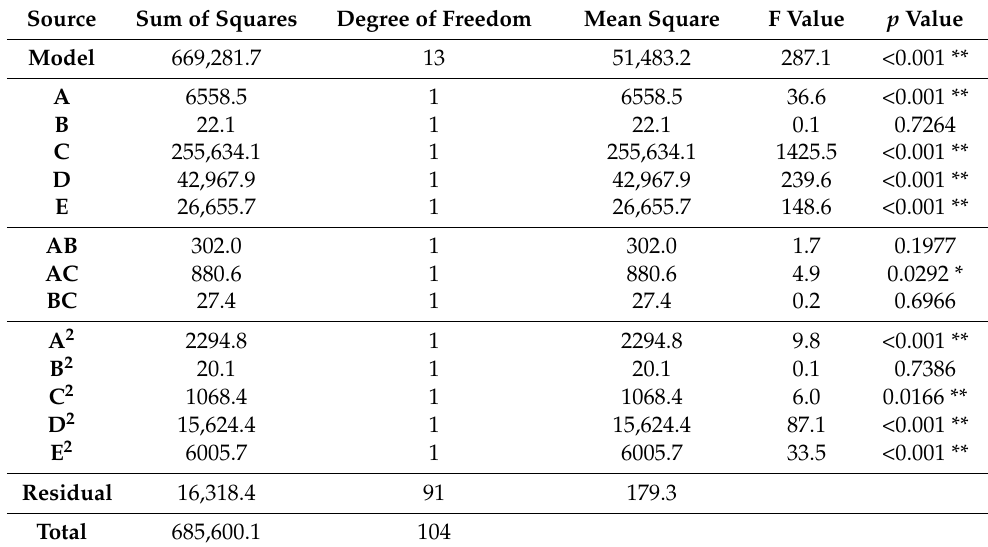
Table 7. ANOVA for fractional factorial experimental design of AR119–NICUS system.